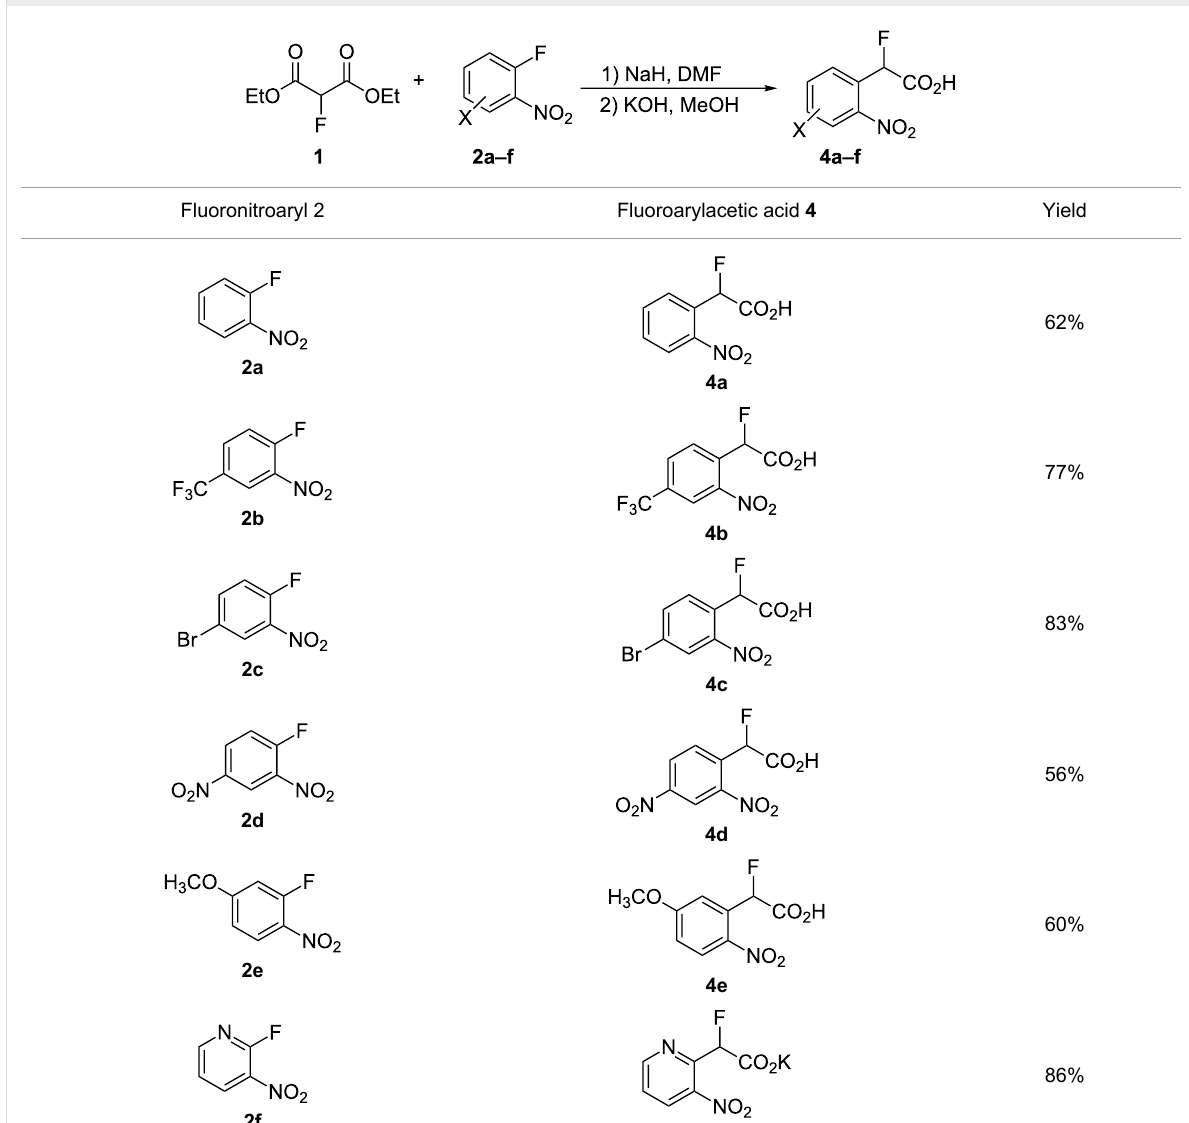
Table 1: S N Ar reactions using fluoromalonate